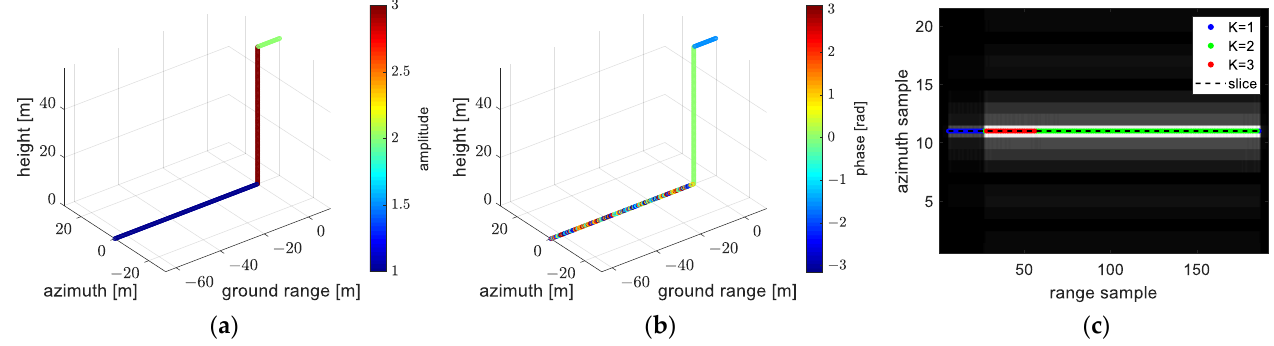
Figure 8. The simulated scenario in experiment 1: ( a ) the amplitude of simulated scatterers, ( b ) the phase of simulated scatterers, ( c ) the 2-D SAR image from master antenna.